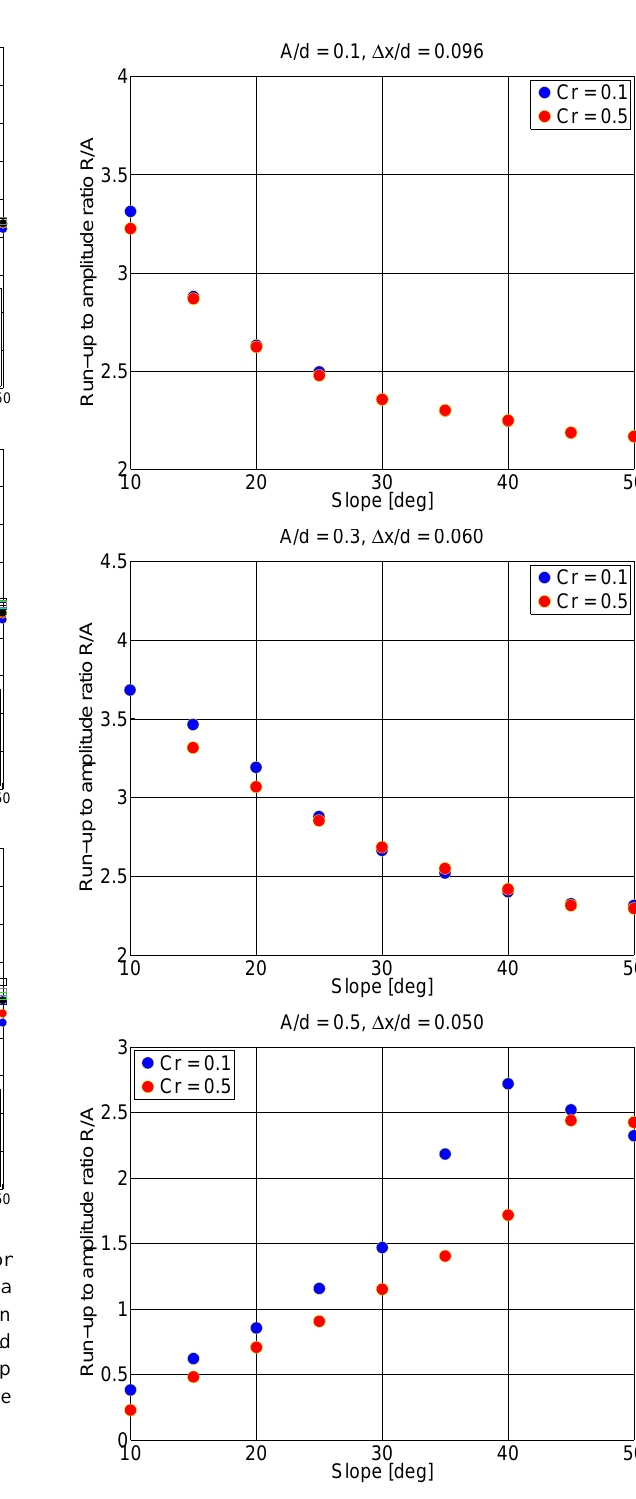
Fig. 4. Run-up ratio for solitary wave run-up using model 1a at dif- ferent slopes, initial amplitudes, and time steps. Here, a grid res- olution n = 200 points per wavelength is employed. Upper panel, A/d = 0 . 1, mid panel A/d = 0 . 3, lower panel A/d = 0 . 5. The drop in the run-up ratio for the largest amplitudes in combination with gentlest slope is due to model